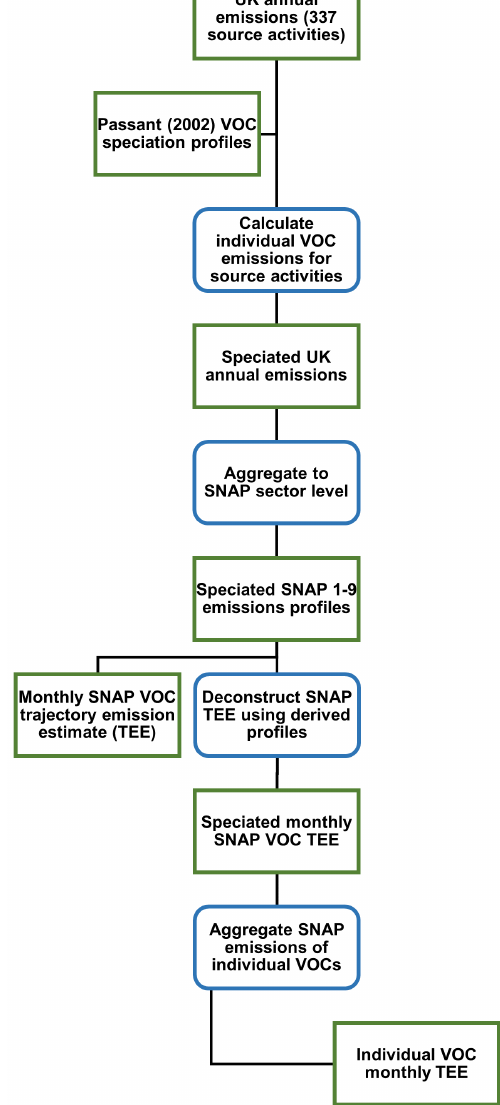
Figure 2. Flowchart demonstrating the process used to calculate the contribution of 630 individual VOCs to the monthly total VOC trajectory emissions estimate (TEE; defined in Sect. 2.3). The green rectangles represent products or data sets, and the blue rounded rect- angles represent processes applied to transform a data set. Further explanation is provided in Sect. 2.3.